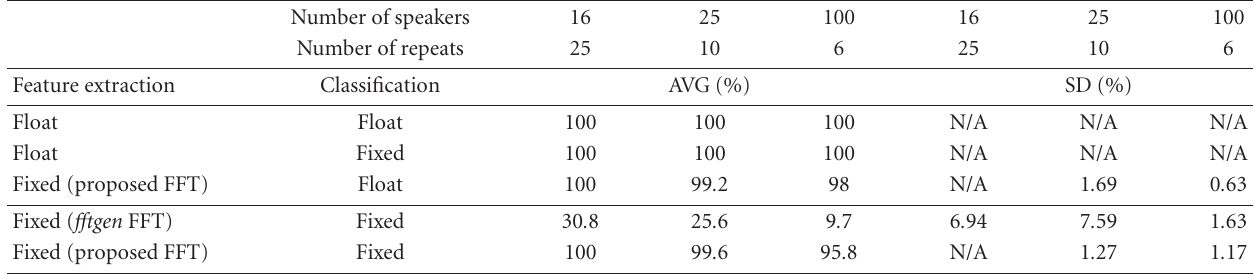
Table 3: Recognition rate average and standard deviation for five di ff erent implementations of the MFCC-based speaker recognition system, varying number of speakers taken from the TIMIT corpus and number of repeated cycles of training, and